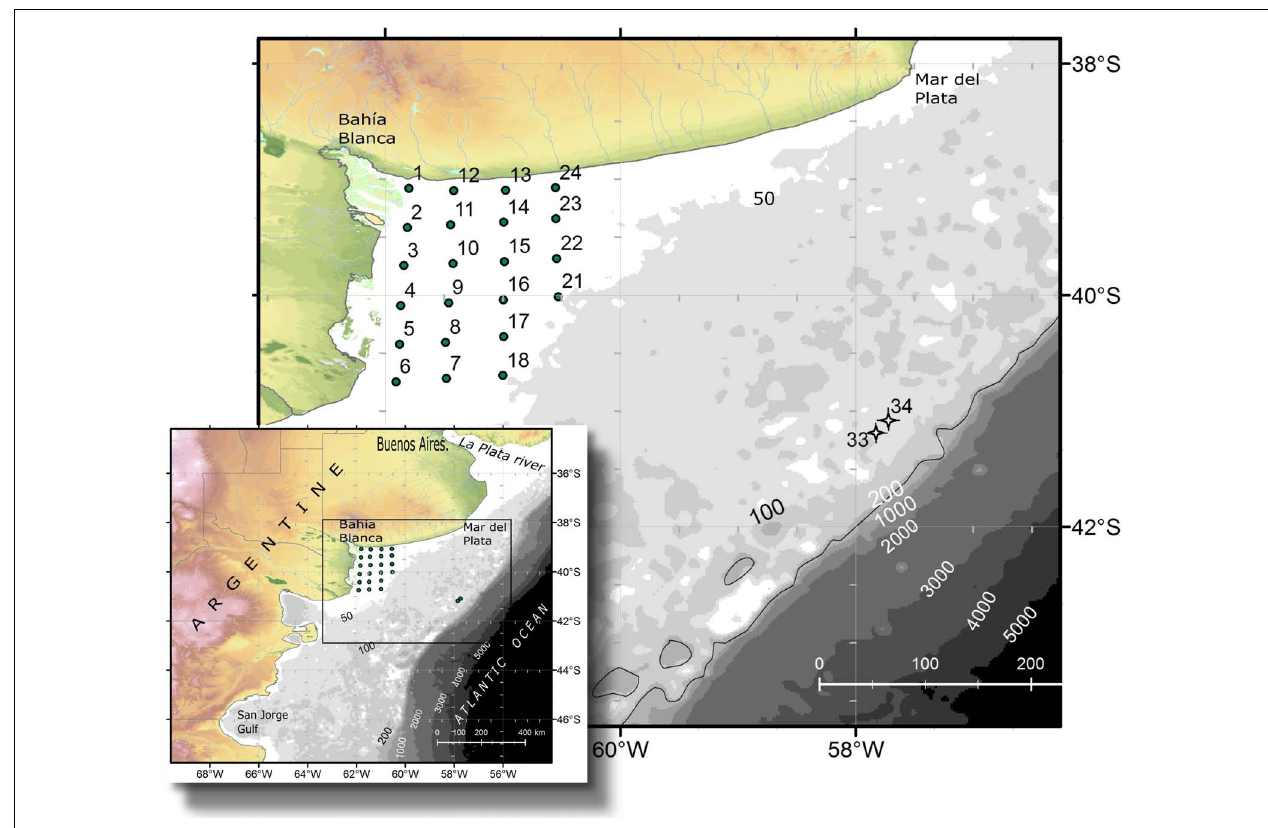
FIGURE 1 | Study area and location of the sampling stations during the oceanographic expedition in September 2015 aboard the research vessel B. Houssay